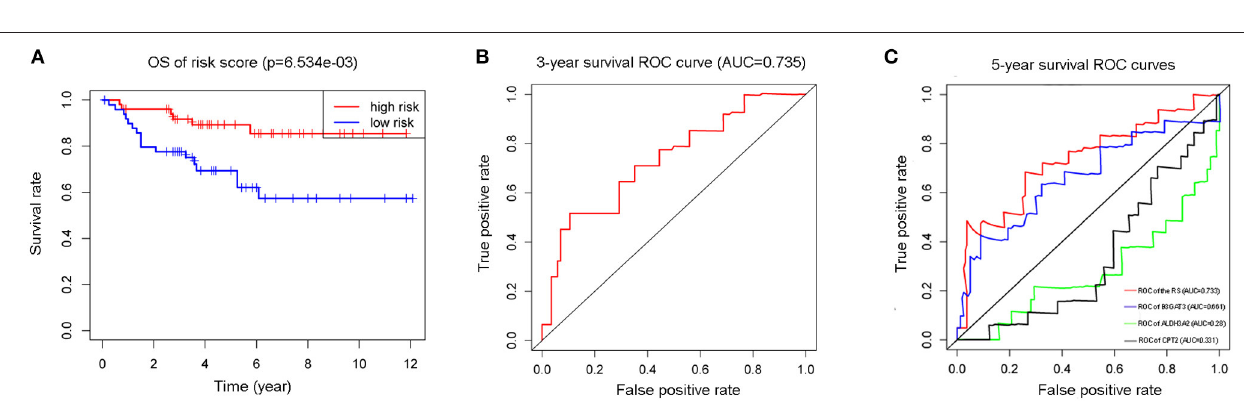
involved in its glycolysis and gluconeogenesis pathways